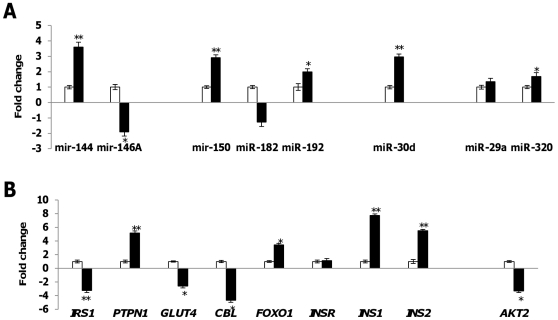

A. Quantitative stem-loop RT-PCR of selected miRNAs in islets with basal glucose concentration of 5 mM (white bars) and high glucose concentration of 25 mM (black bars) and B. Real-time PCR of respective predicted mRNA targets in with basal glucose concentration of 5 mM (white bars) and high glucose concentration of 25 mM (black bars).Data presented as mean ± SEM with n = 3 for each group. Statistically significant differences are tested at p<0.05 significance. *p<0.05, **p<0.01, ***p<0.001. Predictions: miR-144/IRS1; miR-146a/PTPN1; miR-150/GLUT4 and CBL; miR-182/FOXO1; miR-192/INSR; miR-30d/INS; miR-29a and miR-320/AKT2.